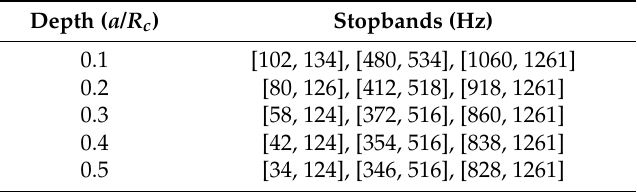
Table 5. Numerical Stopbands derived at different crack depths.